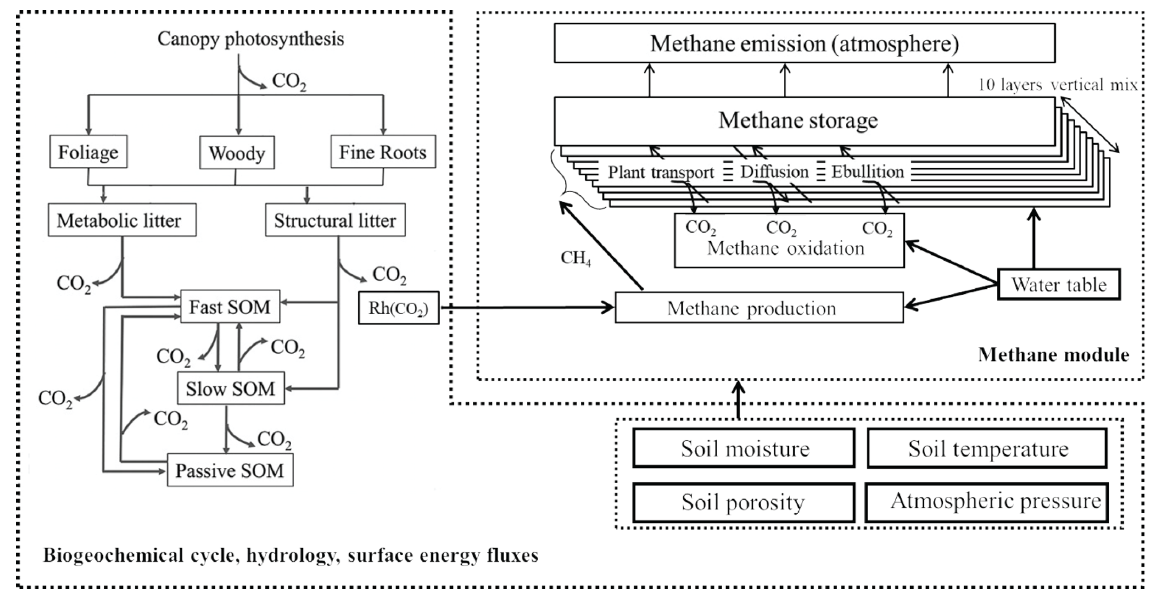
Figure 1. Conceptual structure of the CH 4 emission module in